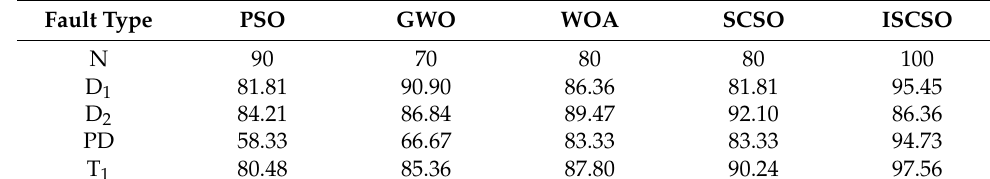
Table 11. Results of Correct Transformer Fault Diagnosis.